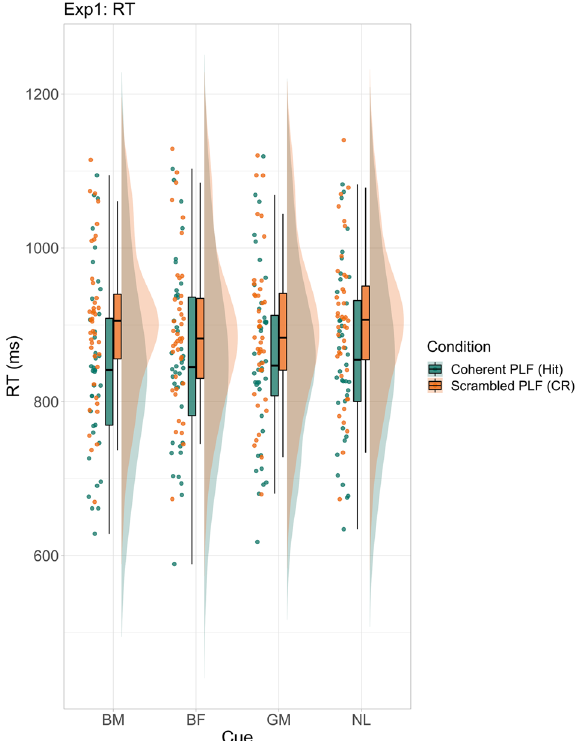
Figure 3. RTs (raw data) for coherent and PLF conditions for Experiment 1. Cue names are as follows: BM biological motion, BF biological form, GM general motion, NL no